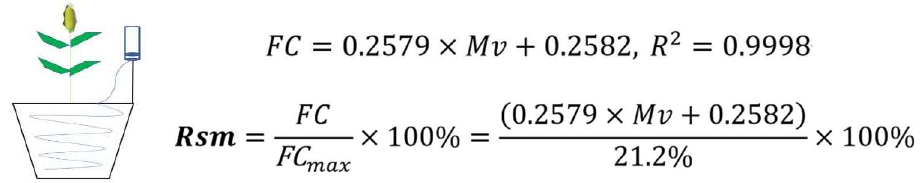
Figure 12. Water control device and first-order equations for soil volumetric and soil weight water content. FC means the field capacity; Mv is the volumetric water content; Rsm means the relative soil moisture; FCmax means the maximum field capacity. R 2 is close to one, indicating a high degree of linear correlation.